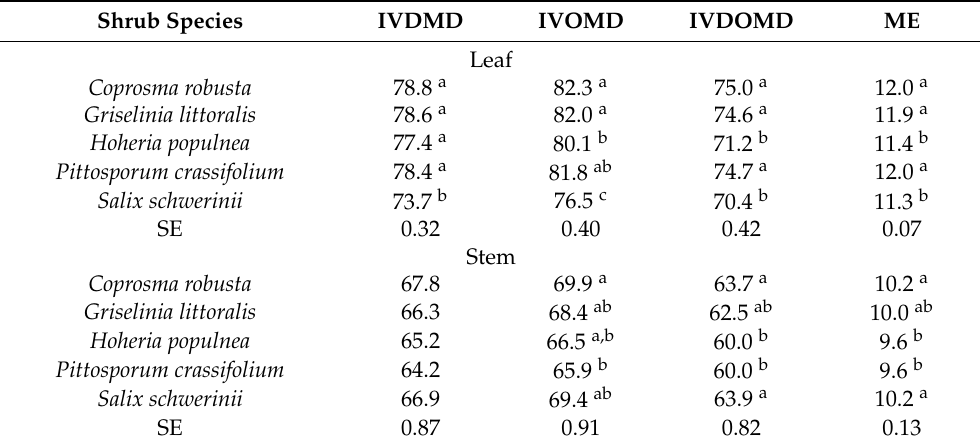
Table 3. Native ( Coprosma robusta, Griselinia littoralis, Hoheria populnea , and Pittosporum crassifolium ) and exotic ( Salix schwerinii ) shrub species leaf ( n = 20) and stem ( n = 20) in vitro dry-matter digestibility (IVDMD, % DM), in vitro digestible organic content in dry matter (IVDOMD, % DM), in vitro organic- matter digestibility (IVOMD, % DM) and metabolizable energy (ME, MJ/kg DM). Shrub Species IVDMD Leaf